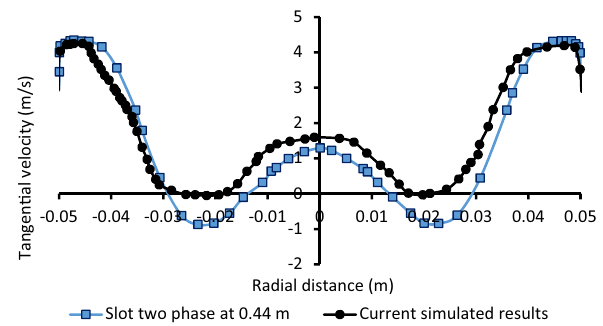
Fig. 5 Comparison of the tangential velocity predicted by the current numerical procedure with Slot et al. (2011) results at 0.44 m below the swirl generator across the diameter of the cylinder [both cases with 2 m/s inlet mixture velocity and 100 mm diameter]